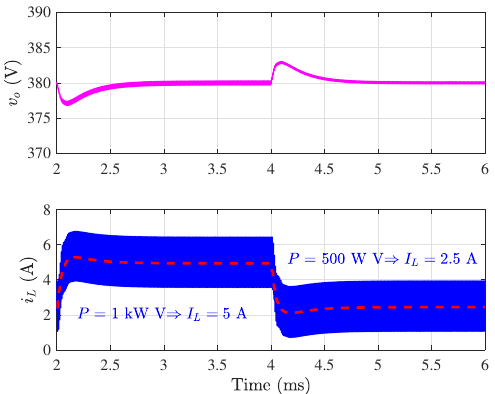
Figure 17. Small-signal transient response in front of 50% step change in the nominal power from numerical simulations using a detailed switched model implemented in PSIM c (cid:13) and the discrete-time